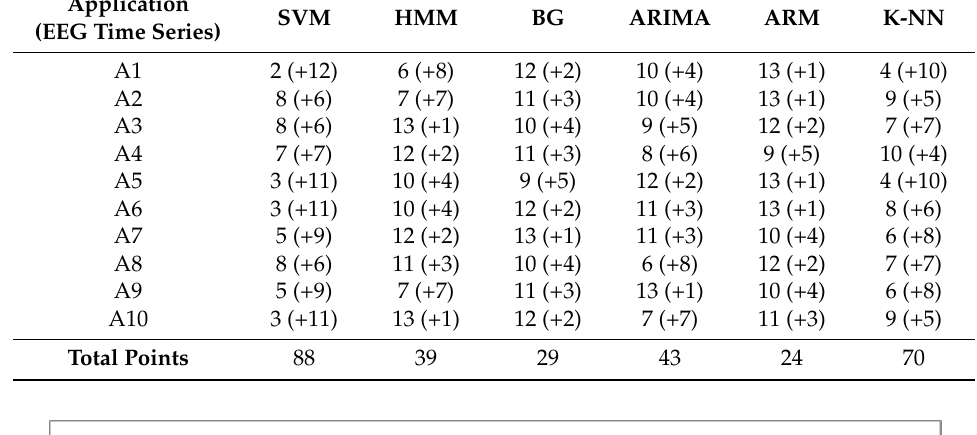
Table 15. The ranks and obtained points from each approach for the prediction of the EEG time series (set 2).